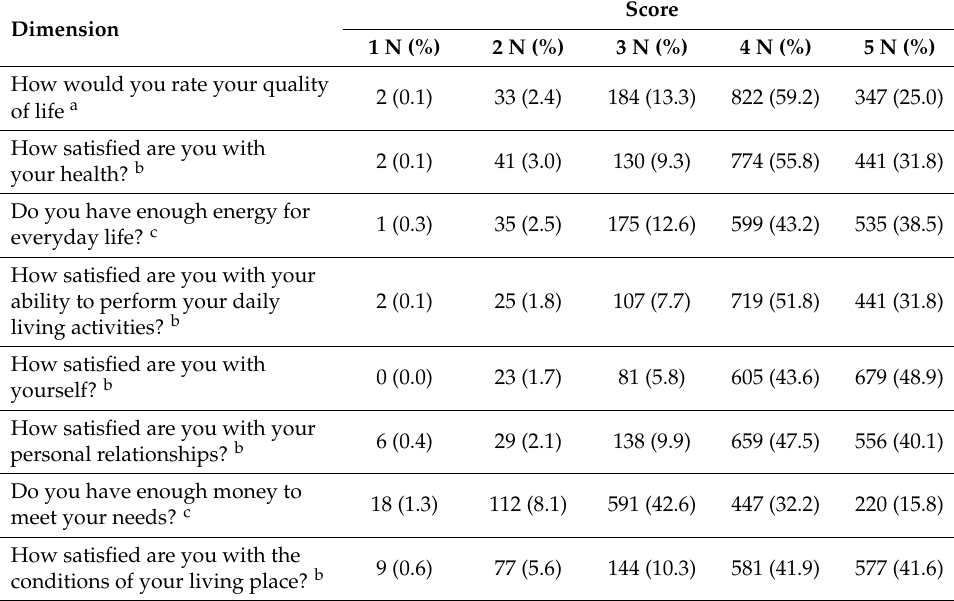
Table 5. Quality of life of the park users evaluated through EUROHIS-QOL 8-items. Score Dimension 1 N (%) 2 N (%) 3 N (%) 4 N (%) 5 N